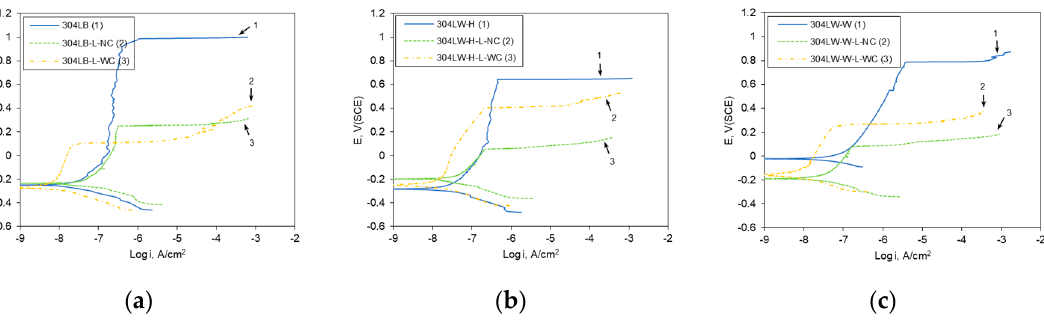
Figure 8. Effect of laser peening on the polarization curves of 304L-surface area (30 °C, deaerated 1% NaCl); ( a ) Base metal, ( b ) HAZ area, ( c ) Weldment.